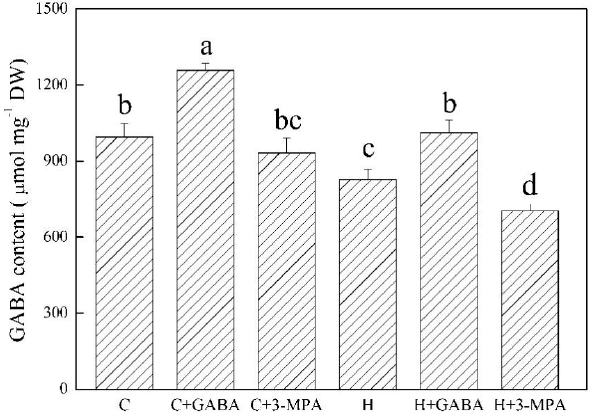
Figure 1. Effects of γ -aminobutyric acid (GABA) and 3-mercaptopropionic acid (3-MPA) on endogenous GABA content in leaf of creeping bentgrass at 30 d of 23/18 (normal condition) or 38/33 °C (heat stress). Vertical bars above columns indicate ±standard error (SE) of means ( n = 4) and different letters above columns indicate significant differences ( p ≤ 0.05). C: control; C+GABA: control+GABA; C+3-MPA: control+3-MPA; H: heat; H+GABA: heat+GABA; H+3-MPA: heat+3-MPA.